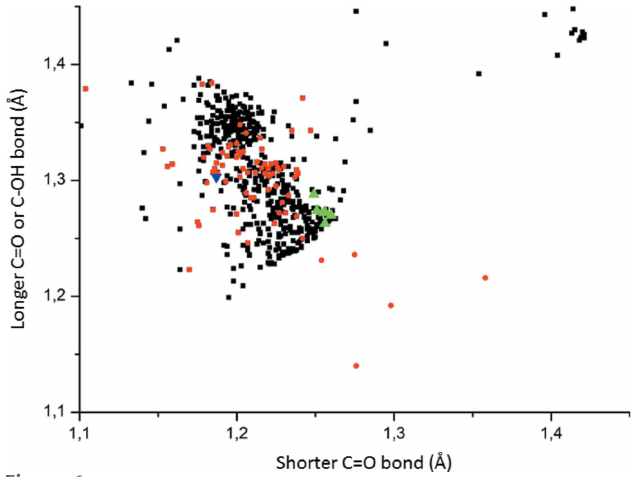
Figure 6 Scattergram of the distances for the shorter and the longer C O bonds in the carboxylate groups in propionates (black squares) as well as of C O bonds and C—OH bonds in propionic acid molecules (red circles). The corresponding values for the propionates and the propionic acid molecule present in the title structure are shown as green and blue triangles,